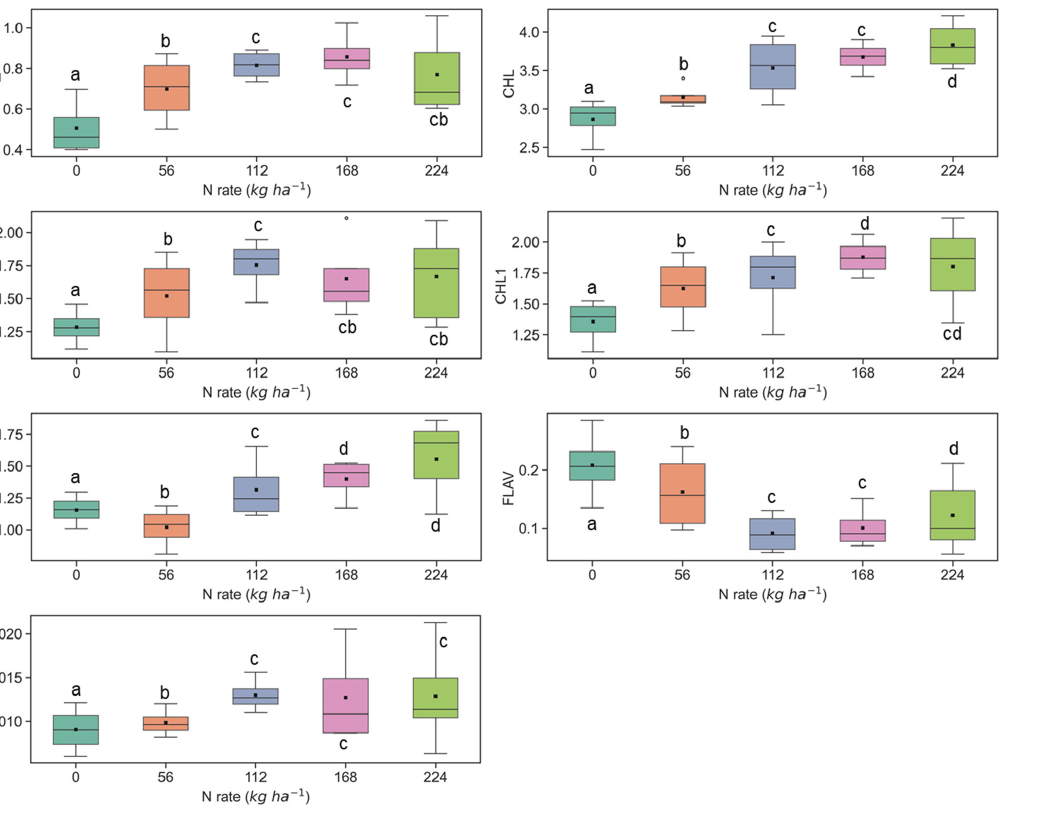
Figure 3. Response of Multiplex fluorescence indices over maize canopy treated with different N application rates at V6 growth stage at the ARDEC site. Different letters (a, b, c, d) designate significant differences according to the Tukey’s HSD test at p < 0.05 significance